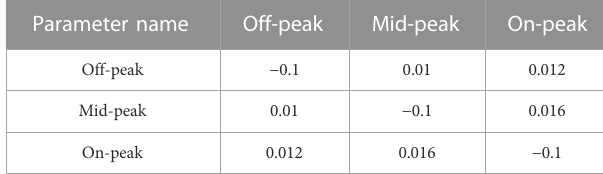
TABLE 4 Electricity price elasticity matrix.